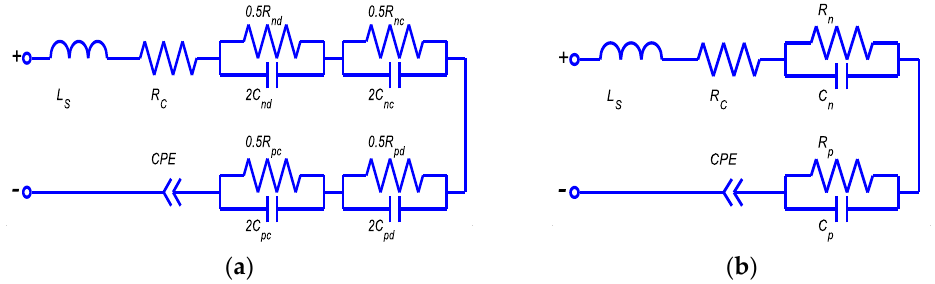
Figure 18. Nonlinear circuits fitting for EIS: ( a ) FPNLC ACequ ; ( b ) BHNLC ACequ .